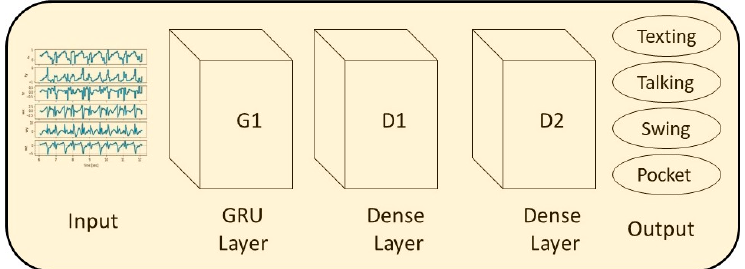
Figure 6. The GRU network architecture used for the evaluation of SLR.